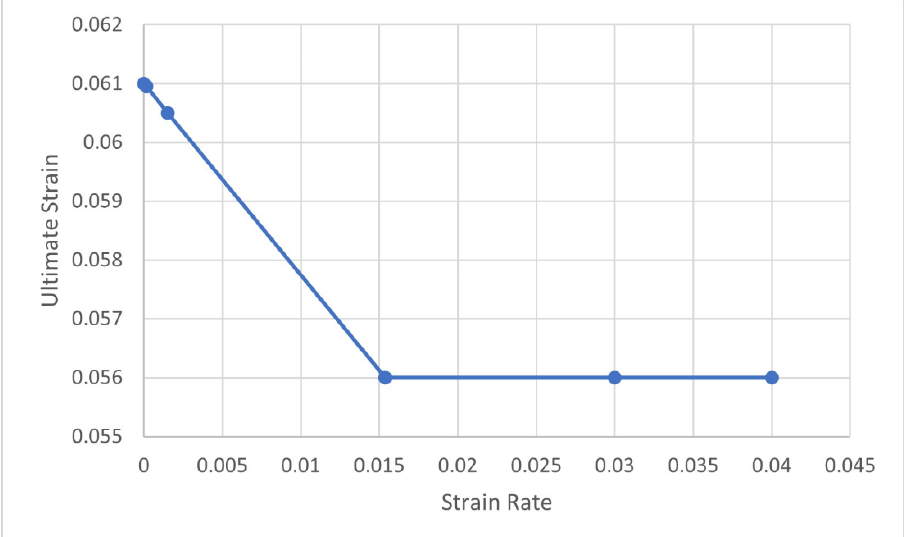
Figure 2. The ultimate strain as a function of the strain rate. The element-deletion criterion is implemented in the VUSDFLD subroutine.